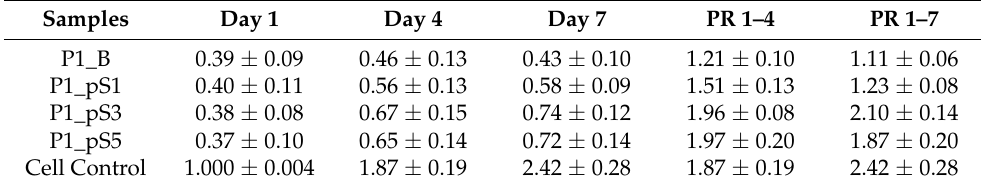
Table 6. Relative cell proliferation calculated as the average of the absorbance in each experimental well, normalized to the average of the absorbance of cell control wells, using day 1 cell population data. Cell proliferation ratios during the initial days of culture calculated as the ratio between cell population on day 4 and on day 1 (PR 1–4) and on days 7 and 1 (PR 1–7). Proliferation rate uncertainty is the combined standard uncertainty.